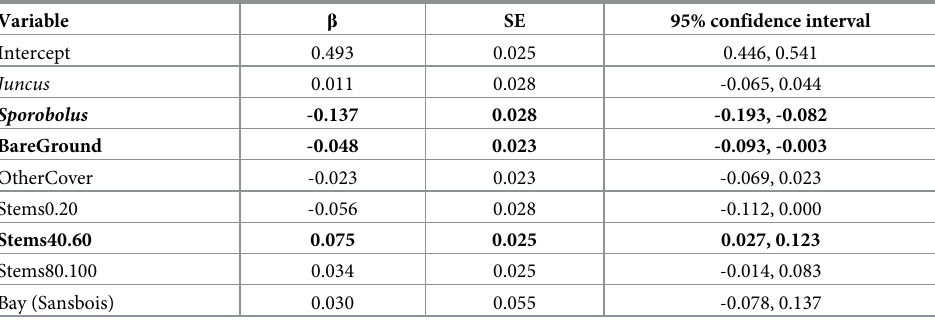
Variables whose 95% confidence intervals did not overlap 0 are in bold . See Table 1 for variable